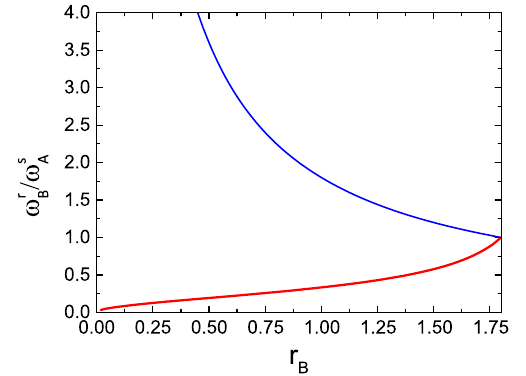
Fig. 7 Frequency shift inside the horizon of a Schwarzschild BH: sig- nals propagating along the homogeneity ( t ) axis, Eq. (54) are redshifted (red) and signals propagating perpendicularly to the t -axis (57) are blueshifted (blue); ( M = 1), r A = 1 . 75